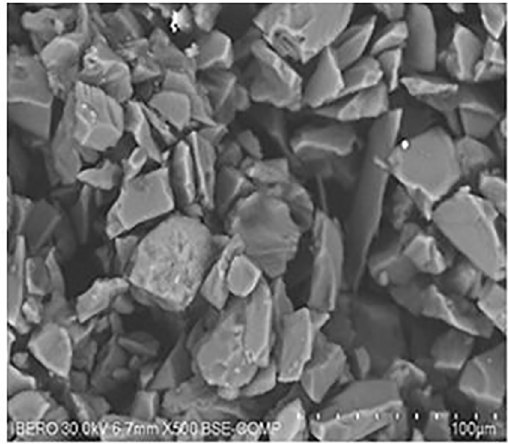
Figure 3. SEM image of boriding agent containing three components B C, KBF and SiC 4 4 metallographically and then etched by Nital solution to reveal the microstructure. The powder-pack boriding was carried out by embedding the samples in a closed-container containing a mixture of powders as shown in Figure 2. The used boriding agent was composed of 20% B